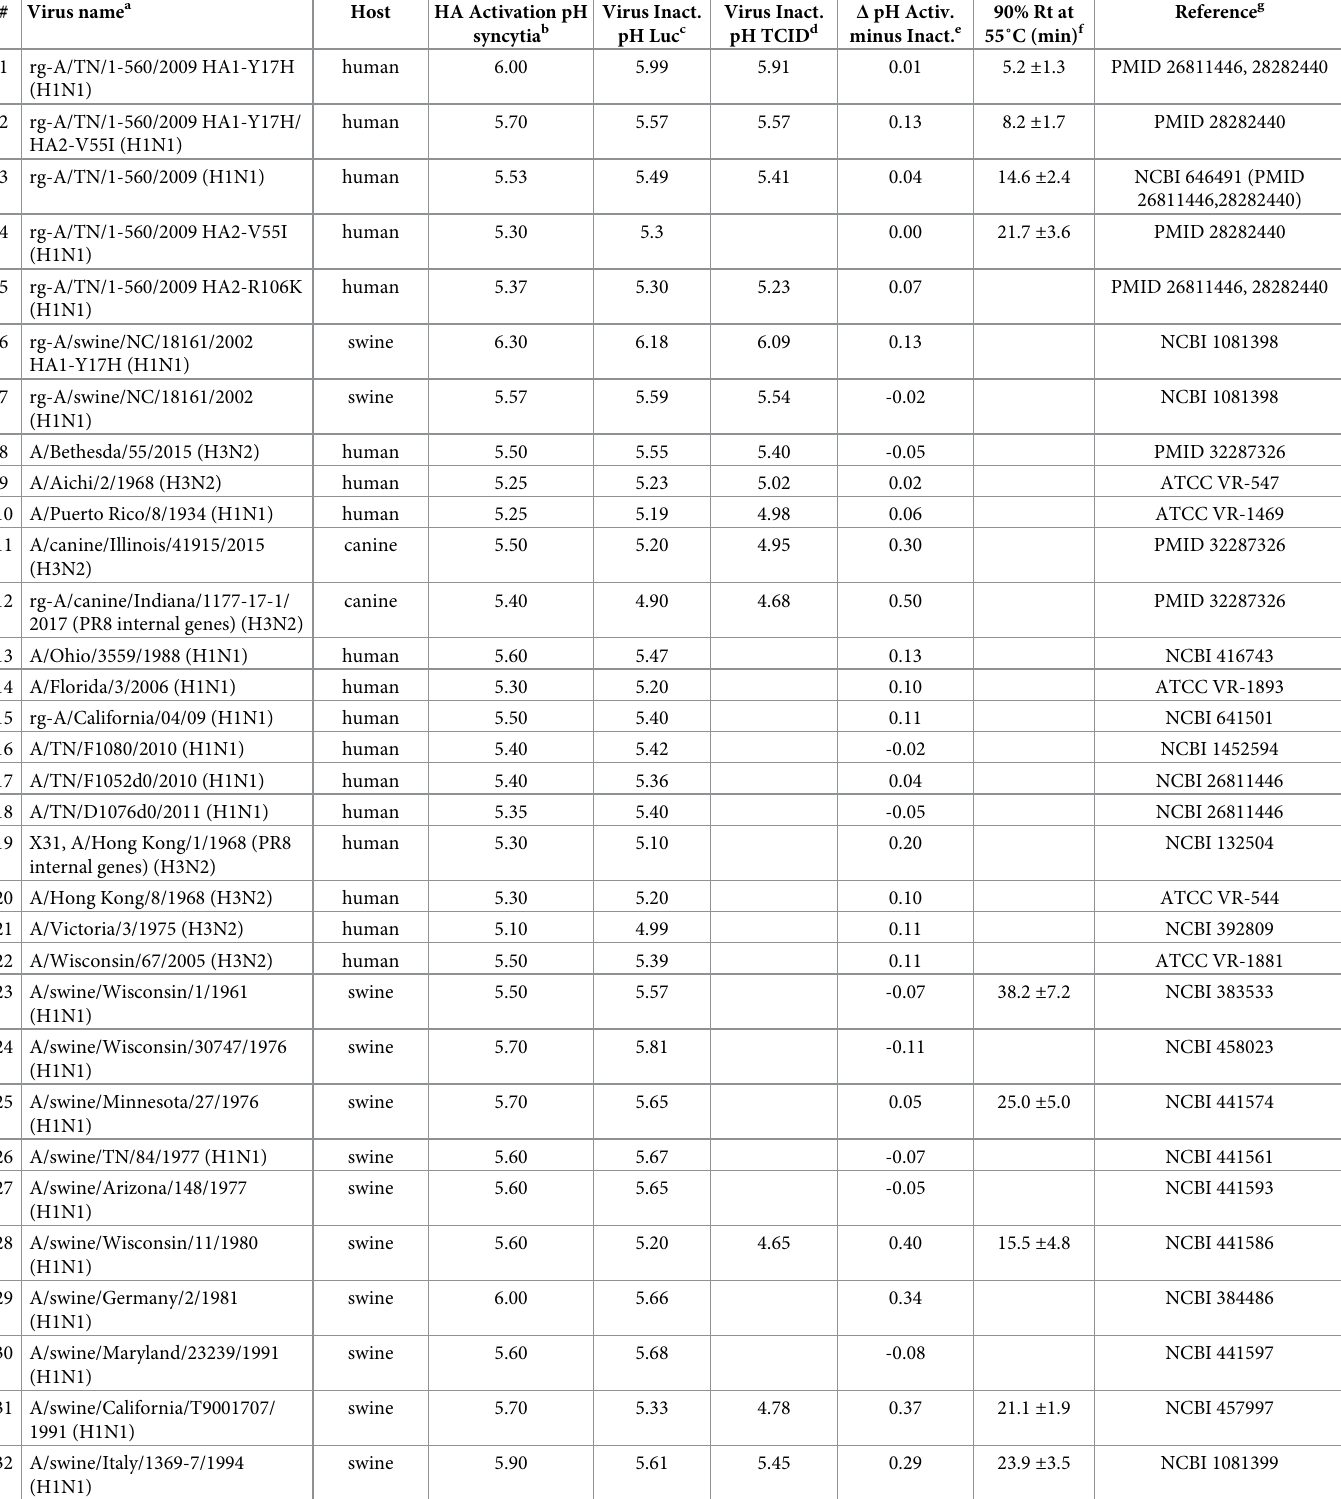
Table 1. Viruses characterized and associated stability